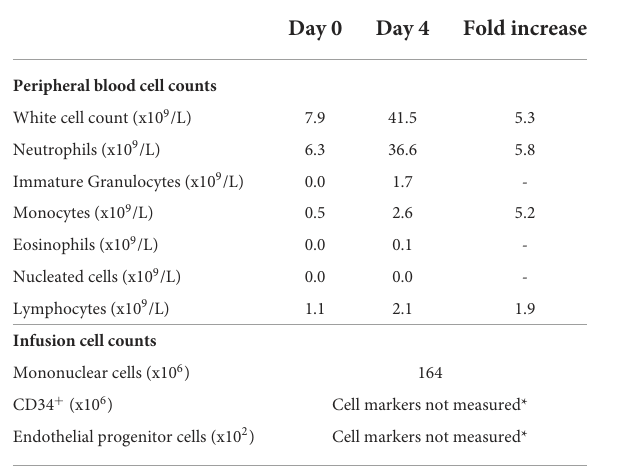
TABLE 1 Cell counts for peripheral blood and cell infusion.